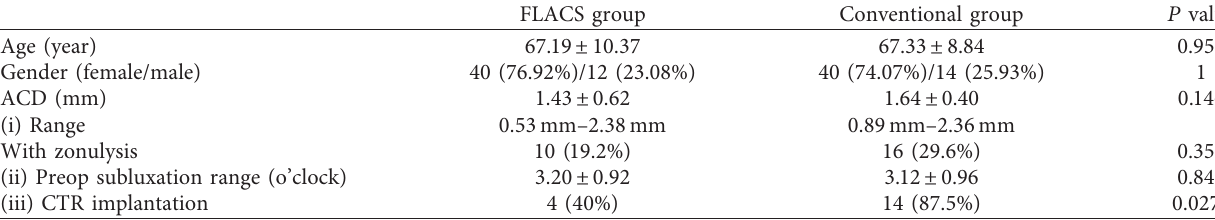
Table 1: Baseline demographics between the two groups.